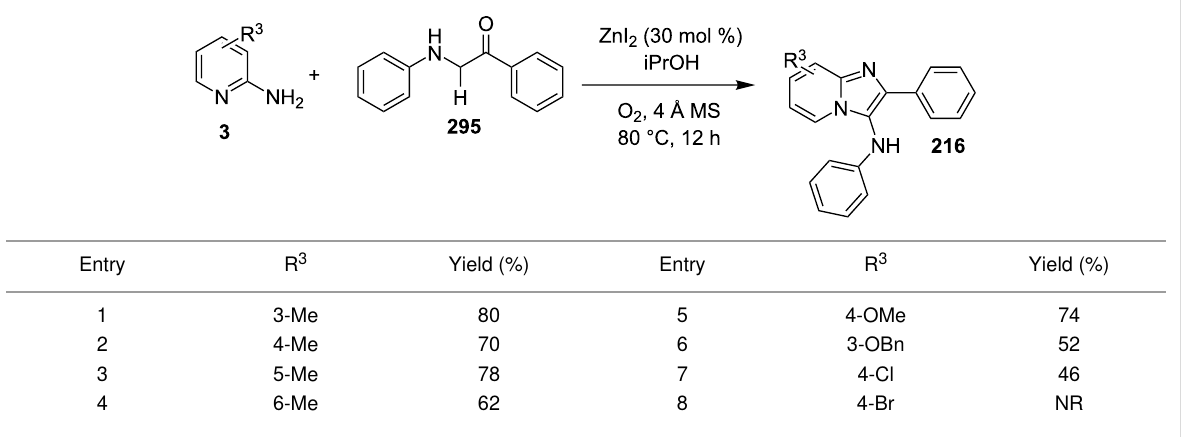
Table 13: Synthetic approach with differently substituted